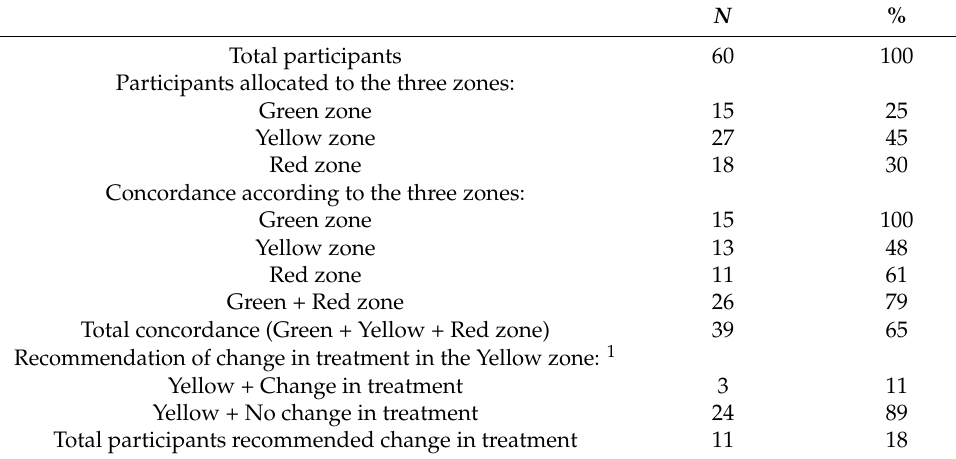
Table 2. MENTOR results and agreement with